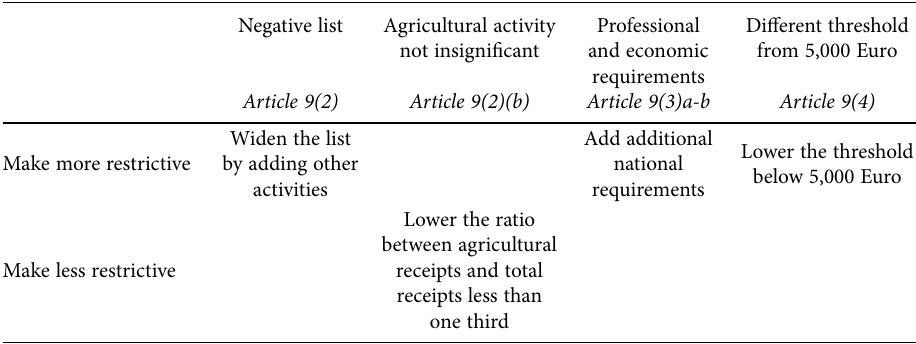
Table 2. Option at Member State disposal in order to make more or less restrictive the rules on “active